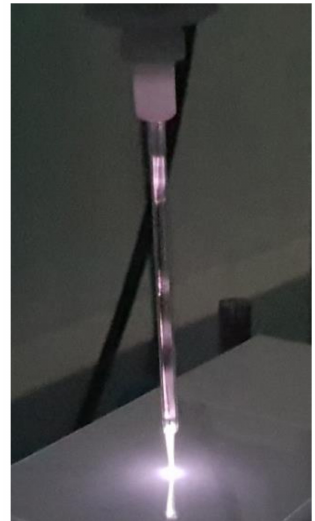
Figure 1. A photo of the atmospheric-pressure plasma jet. The substrate is a wooden plate at a floating potential.